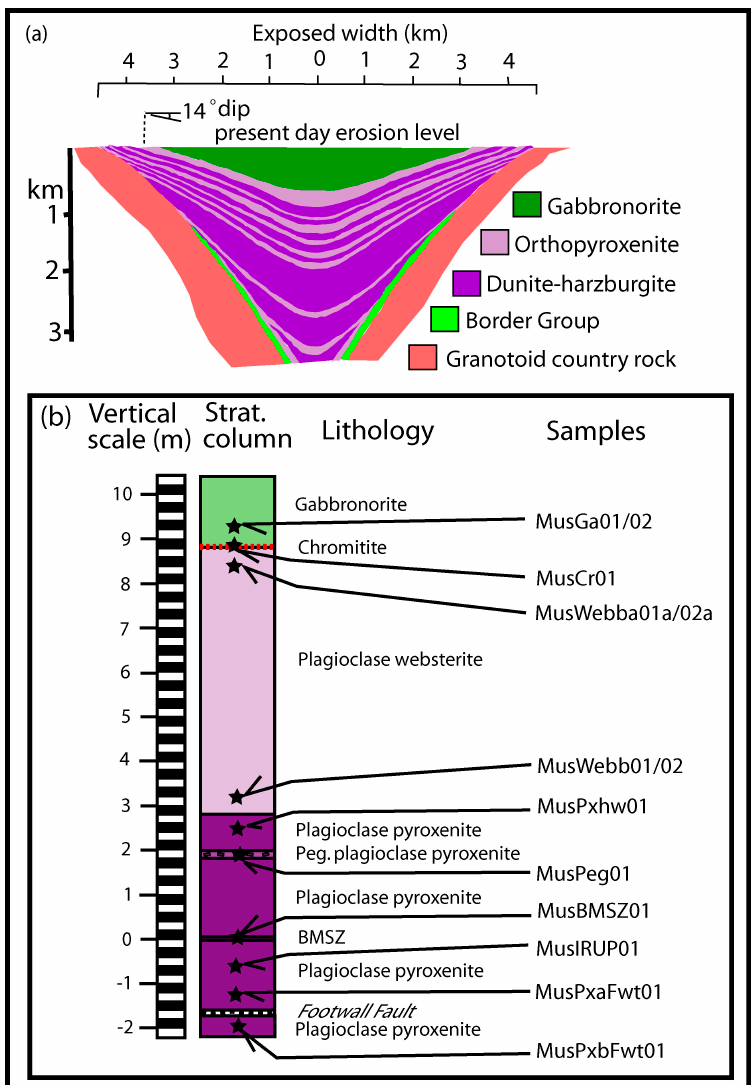
Figure 2. ( a ) Transverse section of the Great Dyke showing attitude of layering and its relationship to wall rocks [25]. ( b ) Stratigraphic section in the Unki Mine area showing location of samples used in this study.